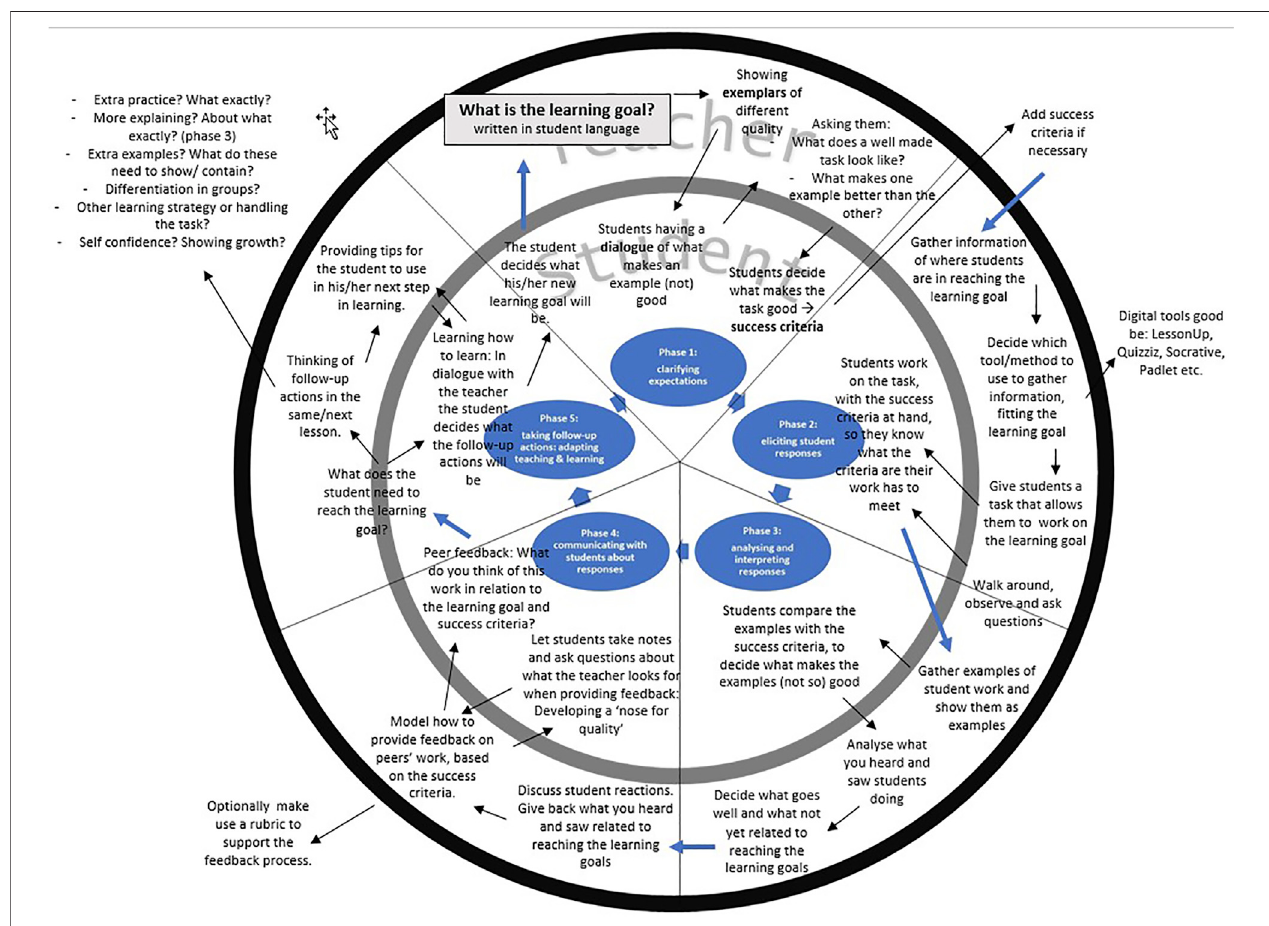
FIGURE 3 | An exemplary student-teacher co-regulatory formative assessment